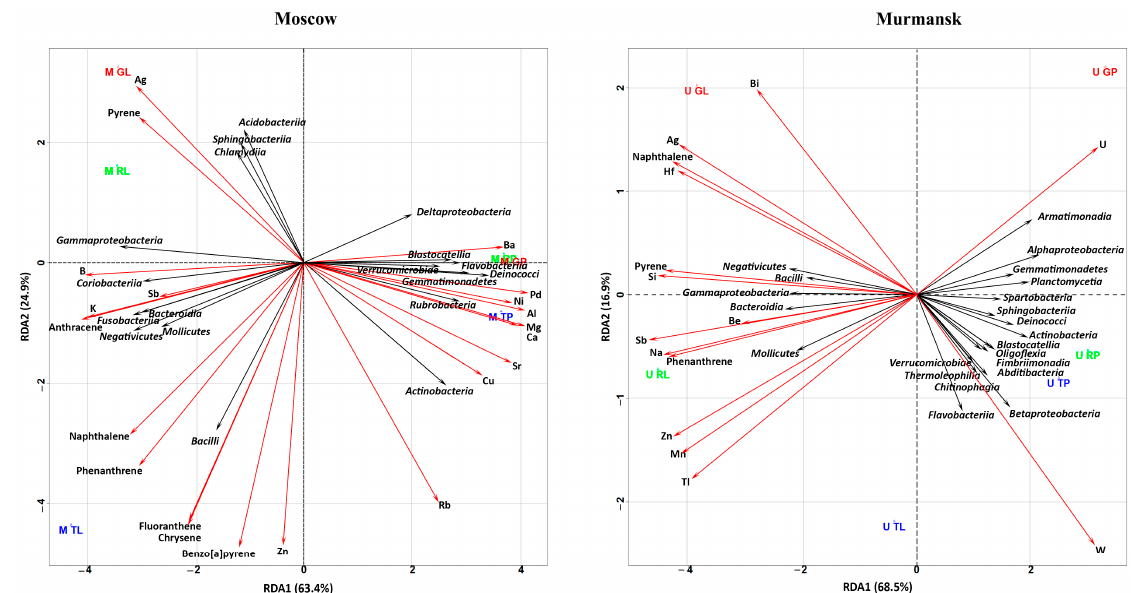
Figure 4. RDA ordination triplot showing the correlations of chemical pollutants (red arrows) and bacterial classes (black arrows) of the leaf dust and road dust from Moscow and Murmansk. The first letter in the abbreviation refers to the city: M–Moscow, U–Murmansk; the second letter refers to the functional zone: T–traffic, R–residential, G–recreational; and the last letter refers to the biotope: L–leaf, P–paved surface. The figures show only those classes of bacteria, metals, and PAHs that had a correlation with each other.